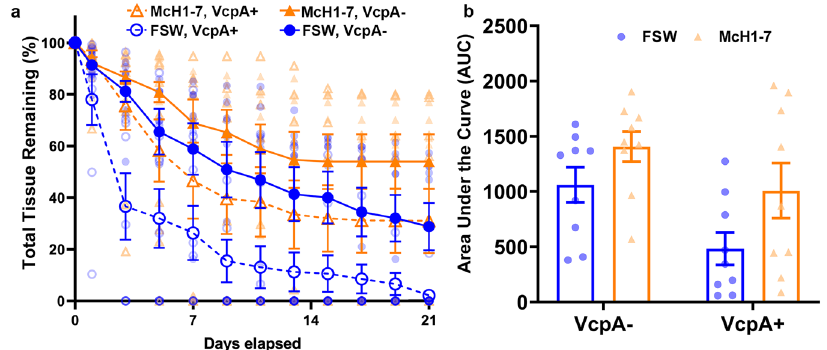
Fig. 4 The relationship between VcpA assay result and McH1-7 ef fi cacy. a Average percent of total tissue remaining on diseased M. cavernosa that are VcpA − and exposed to just FSW (blue solid line with closed blue circles) or McH1-7 (orange solid line with closed orange triangles) as well as was VcpA + fragments exposed to FSW (blue dashed line with open blue circles) or McH1-7 (orange dashed line with open orange triangles). b Area under the curve (AUC) calculations for percent total tissue remaining on the diseased M. cavernosa that are VcpA − and exposed to just FSW (blue bar) or McH1-7 (orange bar) as well as VcpA + fragments exposed to FSW (blue bar) or McH1-7 (orange bar). Two-way ANOVA of the disease progression rates showed that VcpA status ( P = 0.005, n = 9) and treatment ( P = 0.029, n = 9) did have an effect, and there was no signi fi cant interaction ( P = 0.523, n = 9). The error bars represent the standard error of the